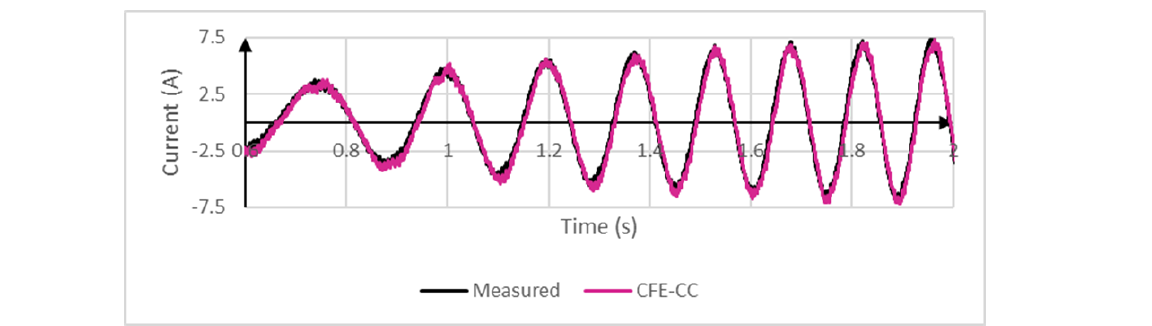
Figure 11. Rotor current in winding a r starting from load operation and suddenly disconnecting the load.